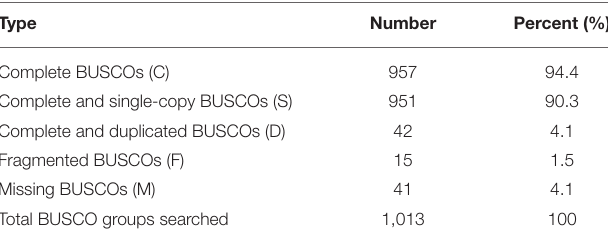
TABLE 2 | Assessment of the completeness of the Capitulum mitella genome assembly by BUSCO.